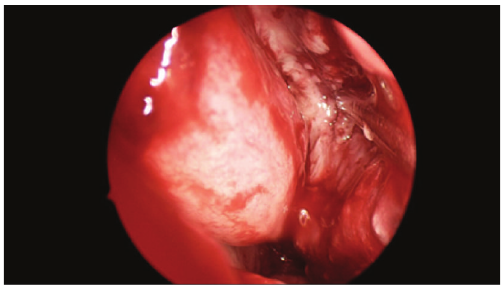
Figure 4: Right nasal vestibule and right septal abscess with boggy, inflamed nasal